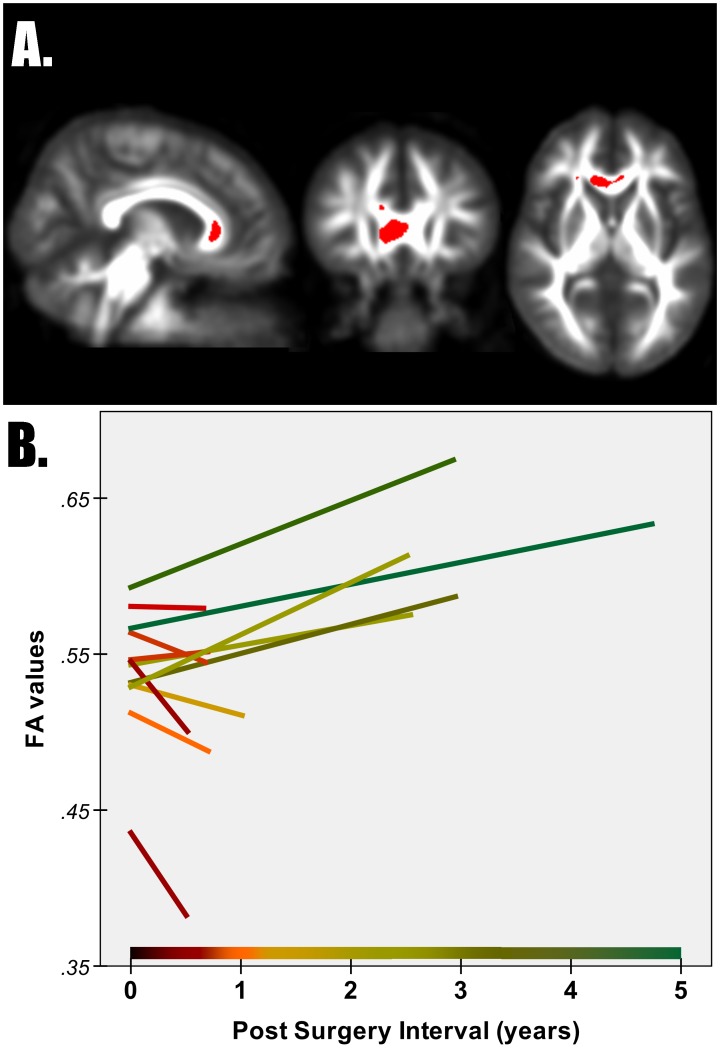
FA change with respect to post-surgery interval.Panel A shows FA change inversely related to post-surgery time interval in the genu of corpus callosum for LATL patients. Panel B shows raw FA values from the 12 LATL patients before (time 0) and after surgery in the same cluster shown in Panel A.